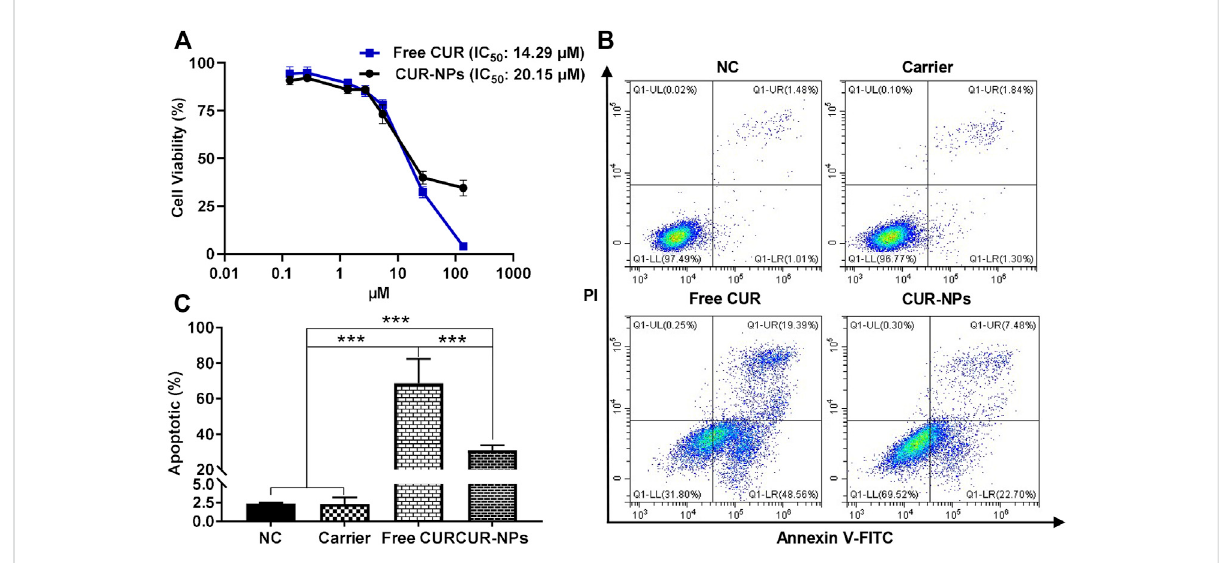
FIGURE 8 CUR and CUR-NPs inhibit proliferation and induce apoptosis of MDA-MB-231 cells. (A) Effects of CUR and CUR-NPs on inhibiting the proliferation of MDA-MB-231 cells. (B) The cell apoptosis was investigated by Annexin V-FITC/PI staining. (C) Histogram analysis showed the percentage of apoptosis. NC, treated with negative control; carrier, treated with the carrier of PEG 5k -b-PLLA 5k ; CUR, treated with free CUR; CUR- NPs, treated with CUR-loaded PEG 5k -b-PLLA 5k nanoparticles. *** p <